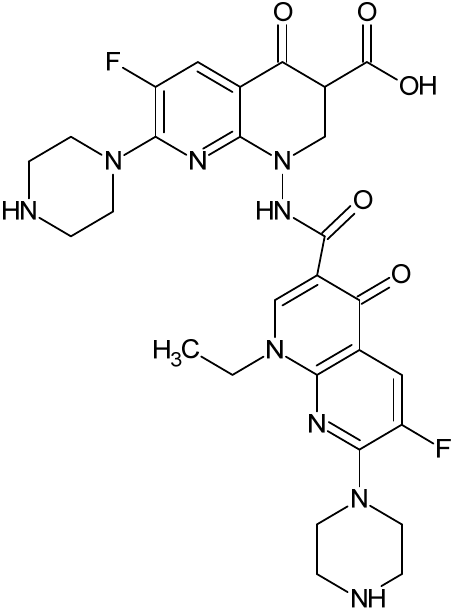
Figure 11. General structure of enoxacin alkyl derivatives prepared by Li et al.